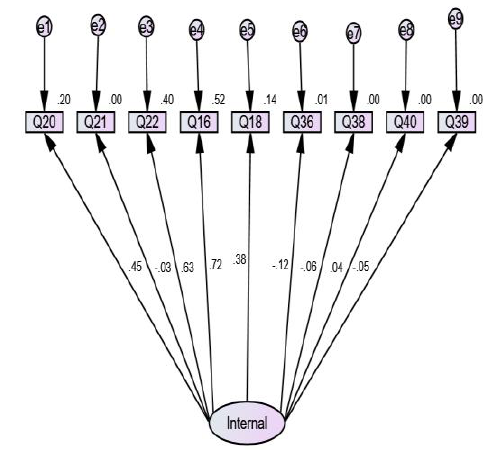
Figure 3. CFA of SYSTEM.